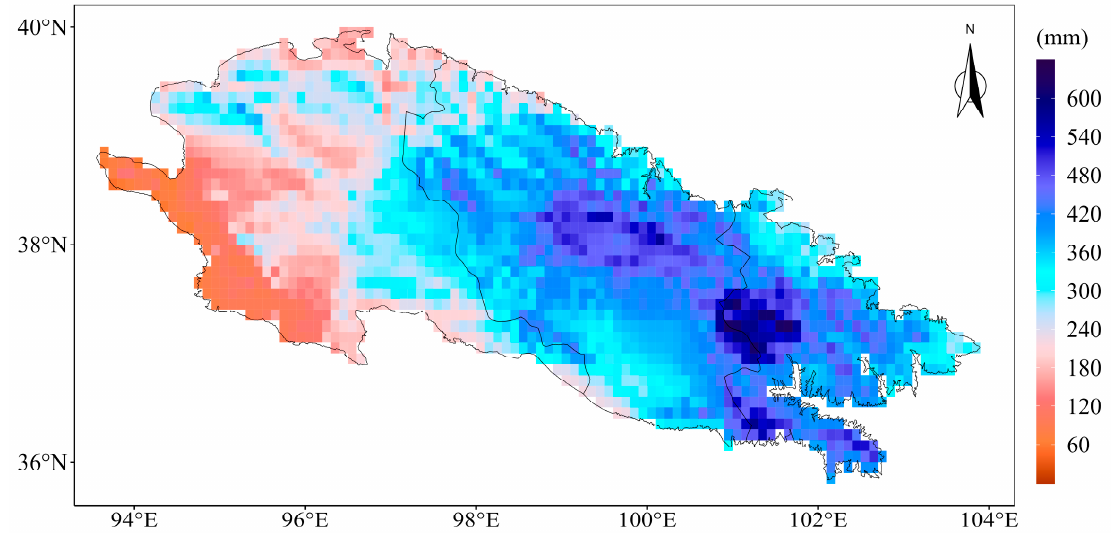
Figure 2. The spatial distribution of the annual average precipitation in the Qilian Mountains from 1970 to 2014 based on the spatial interpolation results.